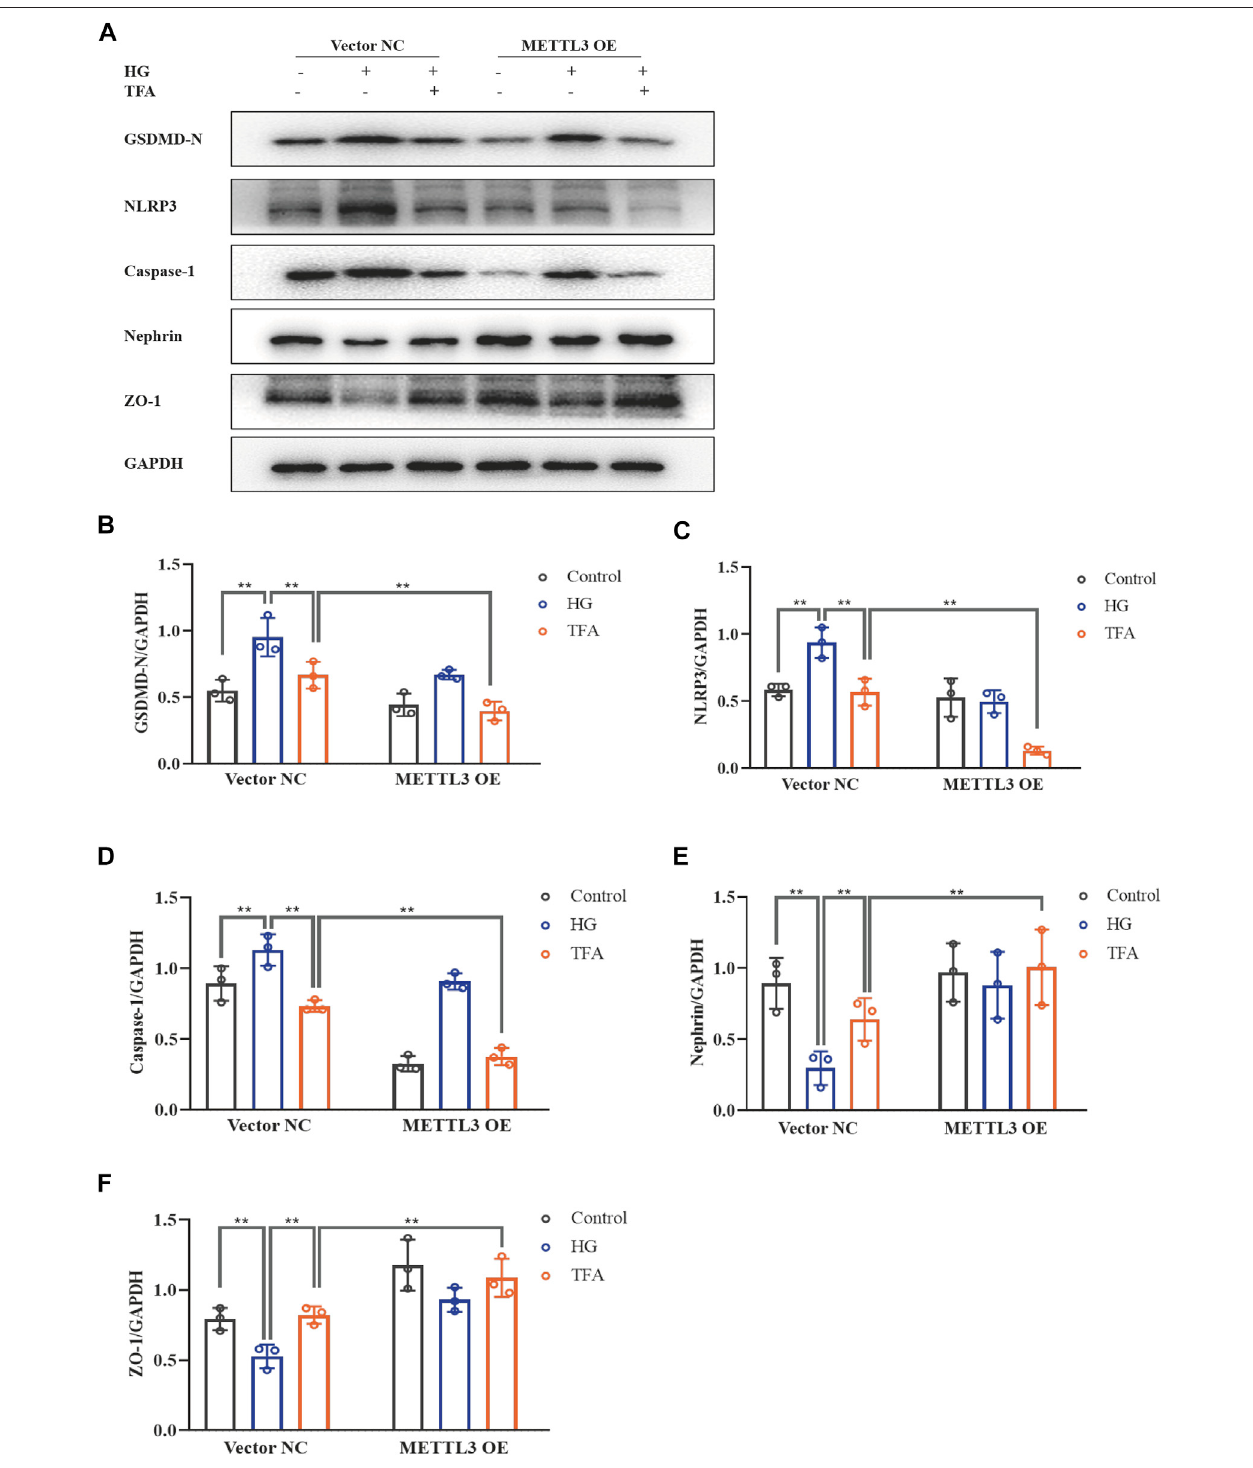
FIGURE 10 | TFA attenuated podocyte pyroptosis and injury in a METTL3-dependent manner by inhibiting the activation of the NLRP3 in fl ammasome in HG- af fl ictedMPC-5cellswithoverexpressedMETTL3. (A) WBanalysisofGSDMD-N,NLRP3,caspase-1, nephrin,andZO-1,incultured MPC-5cellstransfectedwithaNC vector or a METTL3 OE vector for 24 h, following by exposure to HG at 30 mM for 48 h with or without TFA (20 μ g/ml) for 24 h; (B) GSDMD-N was quanti fi ed by densitometry; (C) NLRP3 was quanti fi ed by densitometry; (D) Caspase-1 was quanti fi ed by densitometry; (E) Nephrin was quanti fi ed by densitometry; (F) ZO-1 was quanti fi ed by densitometry. Data are expressed as mean ± S.D., (n (cid:2) 3). * p < 0.05, ** p < 0.01. Abbreviations: TFA, total fl avones of Abelmoschus manihot ; METTL, methyltransferase-like; NLRP3, NOD-like receptor pyrin domain-containing protein 3; HG, high glucose; MPC-5, mouse podocyte cell-5; WB, western blotting; GSDMD-N, N-terminus of GSDMD; Caspases-1, cysteinyl aspartate-speci fi c proteinase-1; ZO-1, Zonula occludens 1; NC, negative control; OE, overexpression.